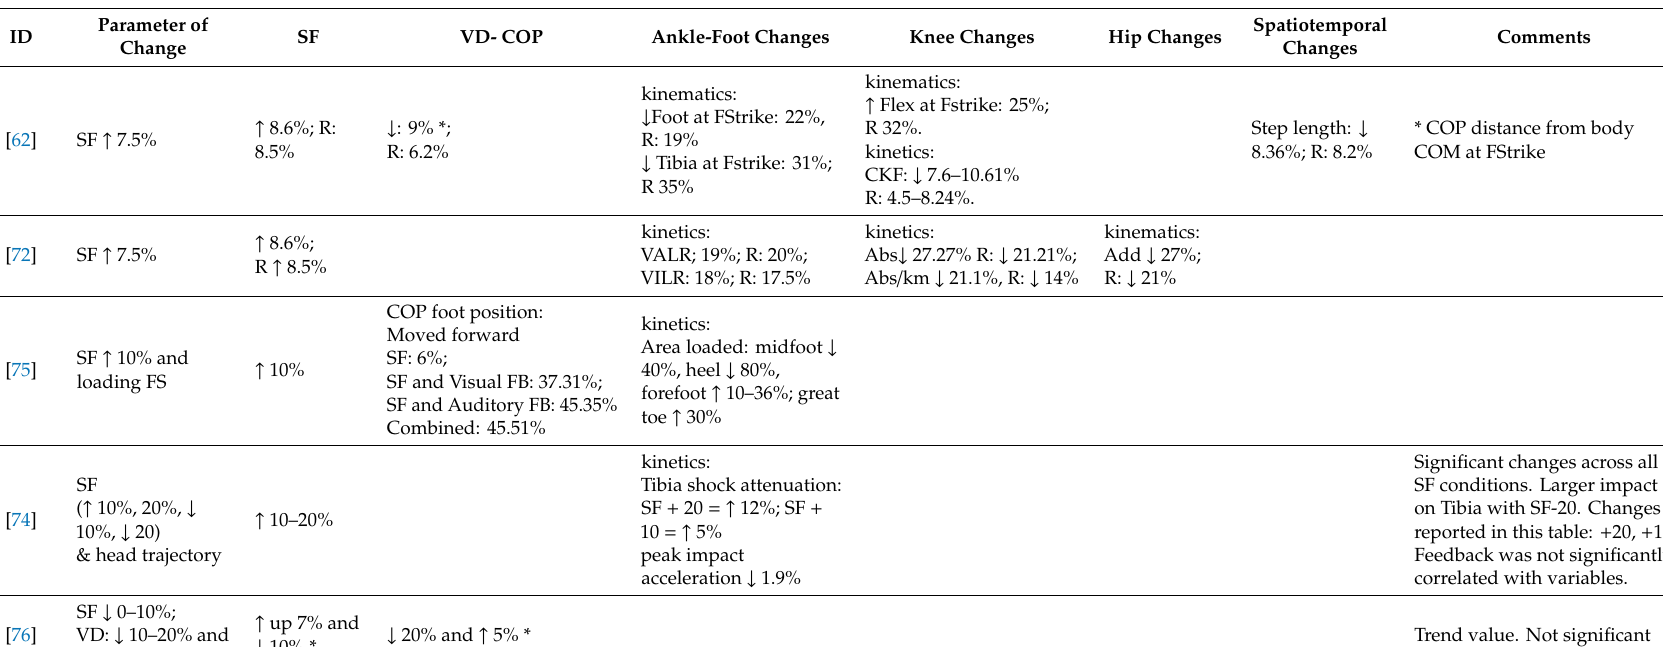
Table 6. Biomechanics changes produced by articles that provided feedback based on